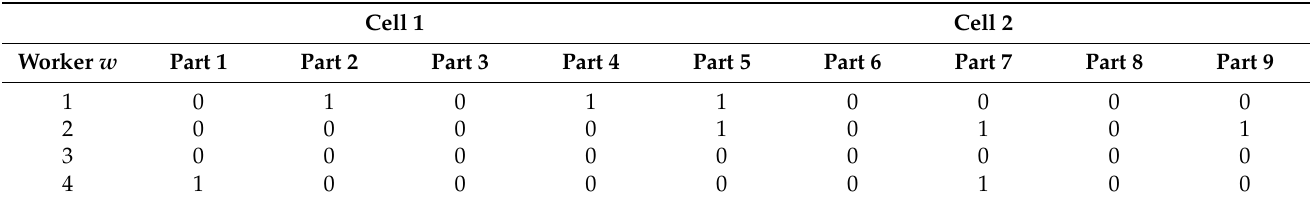
Table 5. Solution of worker-part assignment obtained by NSGA-II for the illustrative example. Cell 1 Cell 2